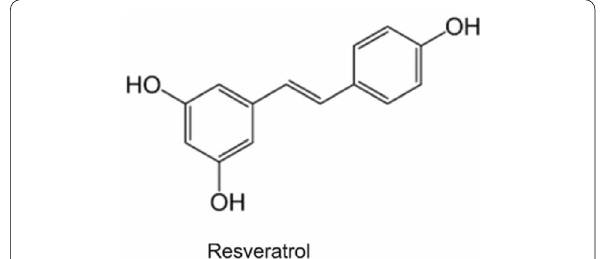
Fig. 7 Chemical structure of Resveratrol